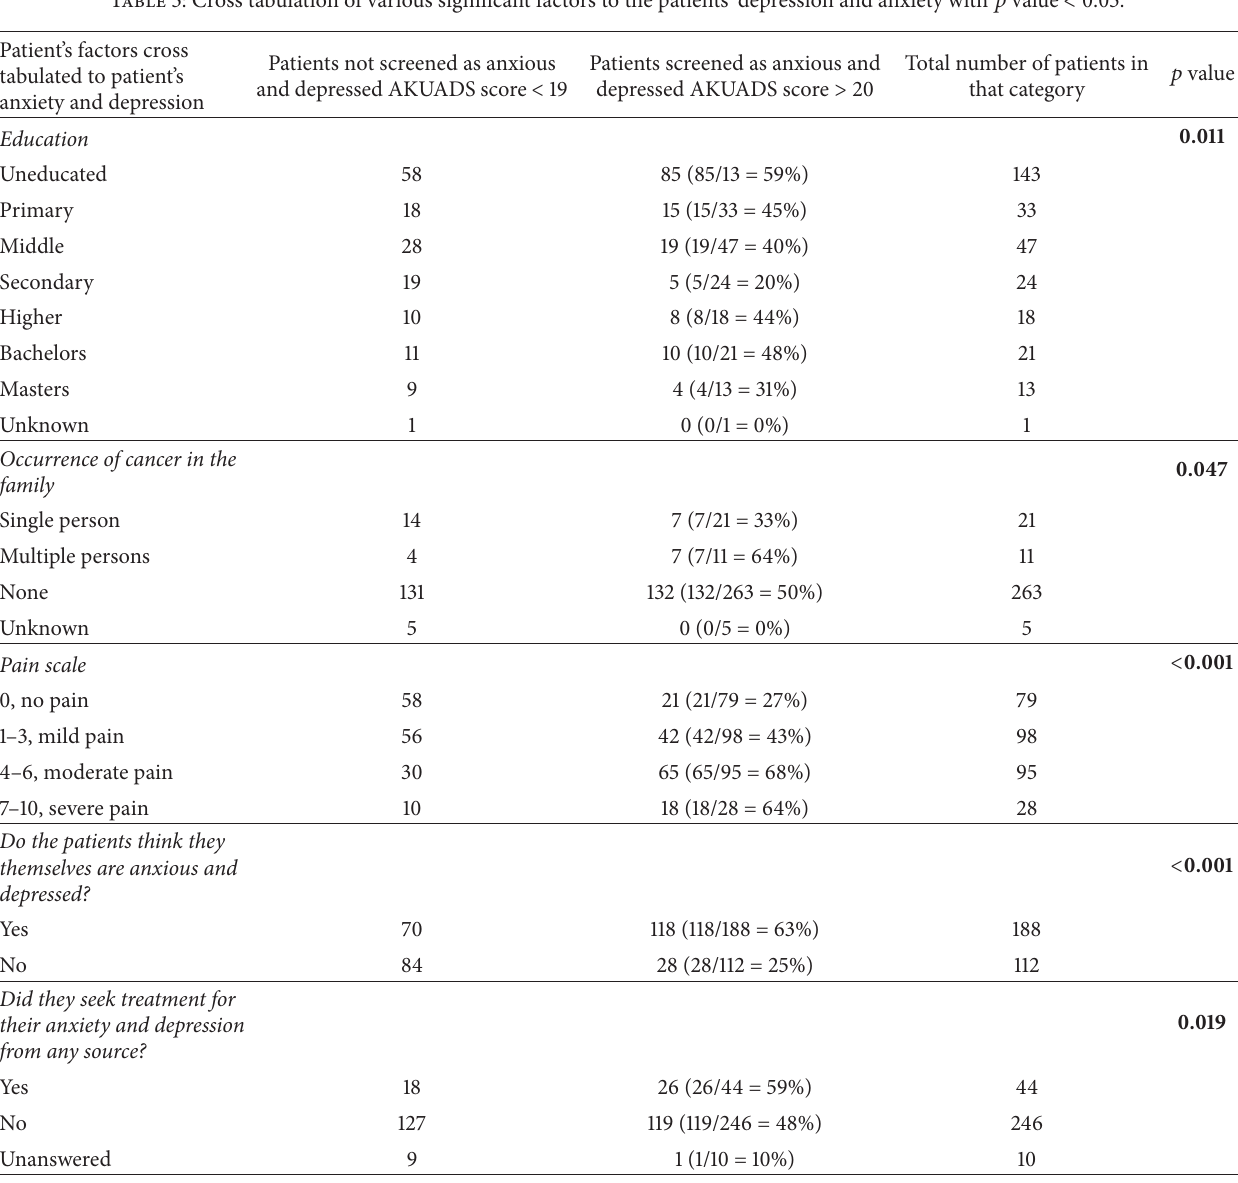
Table 3: Cross tabulation of various significant factors to the patients’ depression and anxiety with 𝑝 value < 0.05.